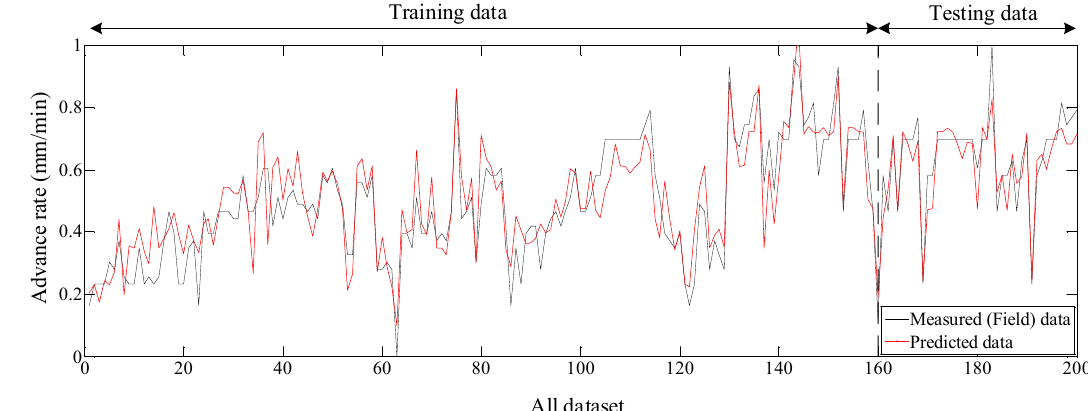
Table 4. The relative deviation of the hybrid ANFIS-GA model.